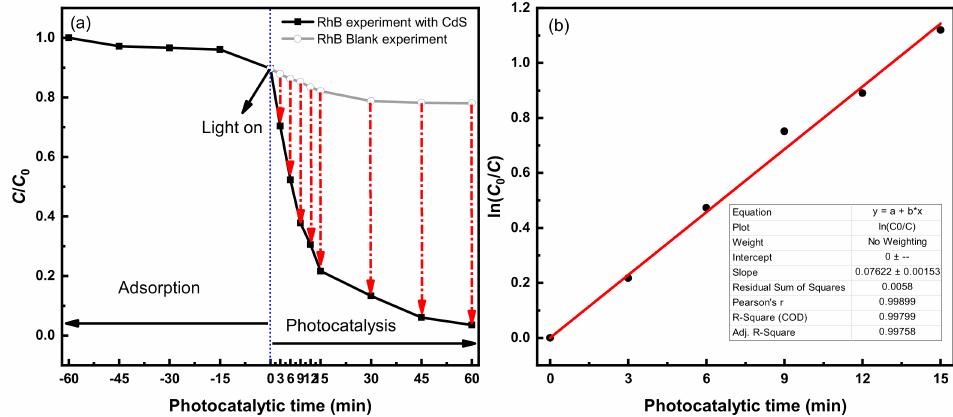
Figure 7. Time-course variation of C / C 0 toward RhB (( a ) C / C 0 vs. time; ( b ) ln( C 0 / C ) vs. time).